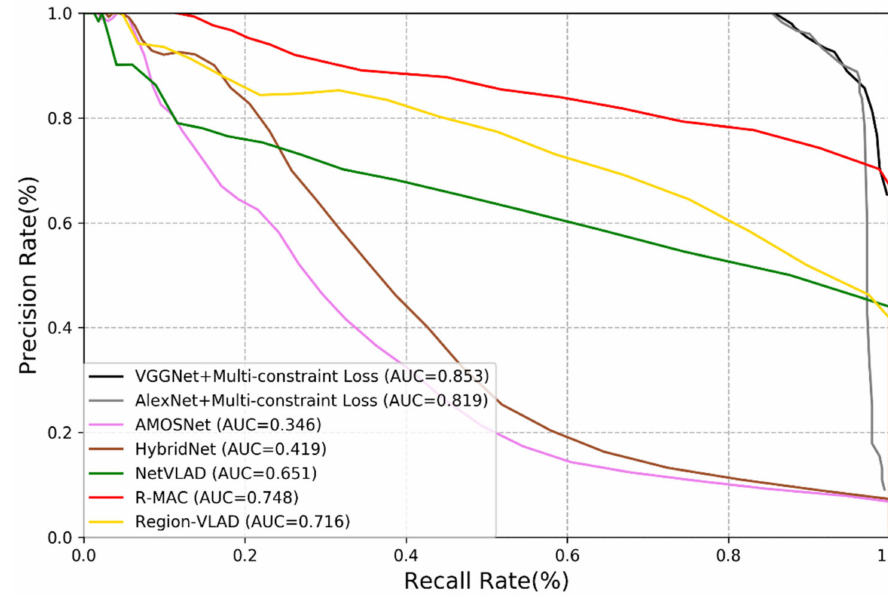
Figure 6. Precision-recall curve of different methods on the TUM